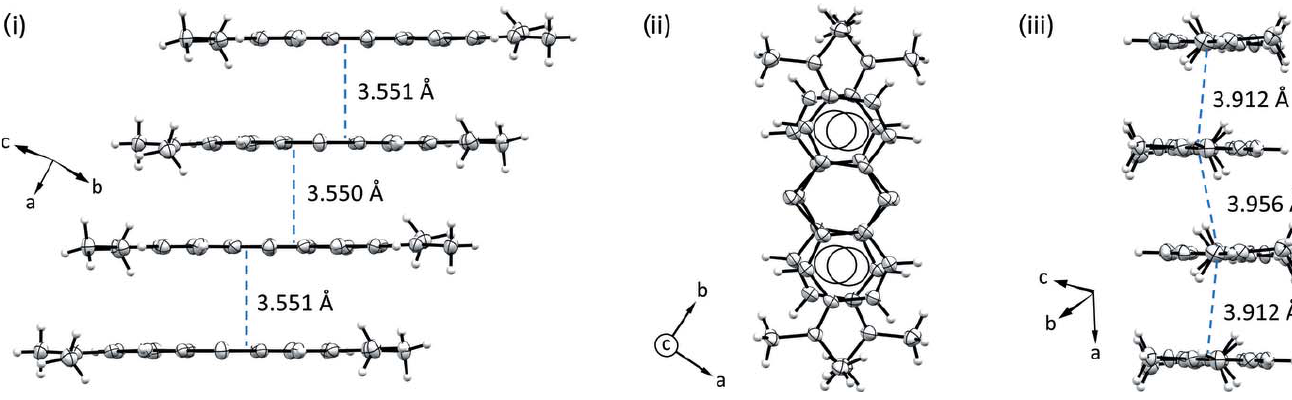
Figure 6 Views of the stacking geometry of MB + in compound ( II ): (i) displayed orthogonally to the stacking pillar axis by showing a tetramer of stacked molecules; (ii) the same group of MB + cations is shown along the stacking direction; (iii) view along the MB + longer dimension, highlighting the nearly completely eclipsed superposition of the cations in the antiparallel